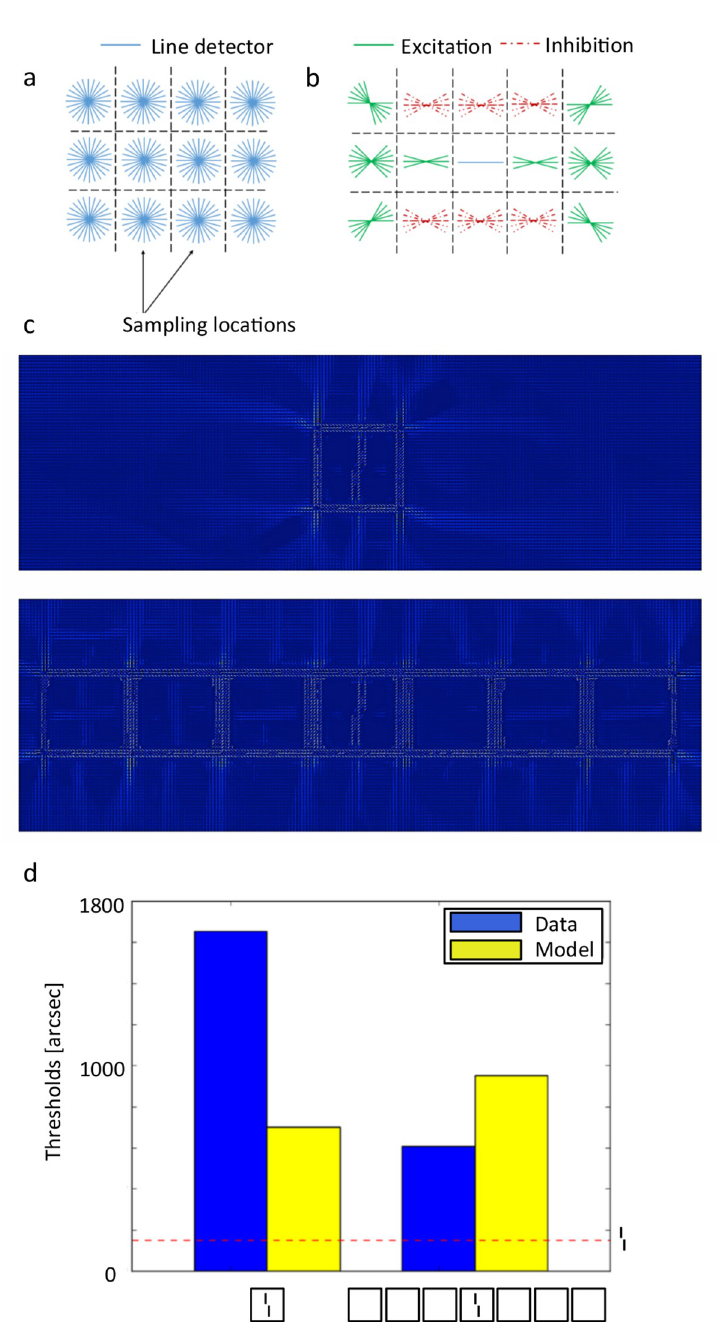
Fig 9. V1 Segmentation model. a. The input is sampled at each grid position by neurons tuned to 12 orientations, mimicking V1 simple cells. b. The connectivity pattern between cells depends on their relative position and orientation as shown here. Solid lines indicate excitation and dashed lines indicate inhibition. As shown, each neuron excites aligned neurons and inhibits non-aligned neurons. Each neuron has the same connectivity pattern, suitably rotated and translated. c. Output images for the square category. Each small oriented bar shows the maximally active orientation at this grid position. d. Results for the squares category. The dashed red bar shows the vernier threshold, which is matched for humans and the model. As shown, uncrowding does not occur in the model, because performance is worse for the 7 squares than the 1 square stimulus. Note: the model outputs a cross-correlation quantifying how similar the model output is to the model output in the vernier alone condition (so the higher this cross-correlation, the better the performance). To make comparison with the human threshold easier, we applied the same procedure as we did for the epitomes, i.e., we applied the following monotonic transformation to the output: “threshold-like output” = 1/”raw output”. Then we scaled the result to be in the same range as the human results. This monotonic re-scaling does not change the conclusions–the phenomenon of uncrowding cannot be